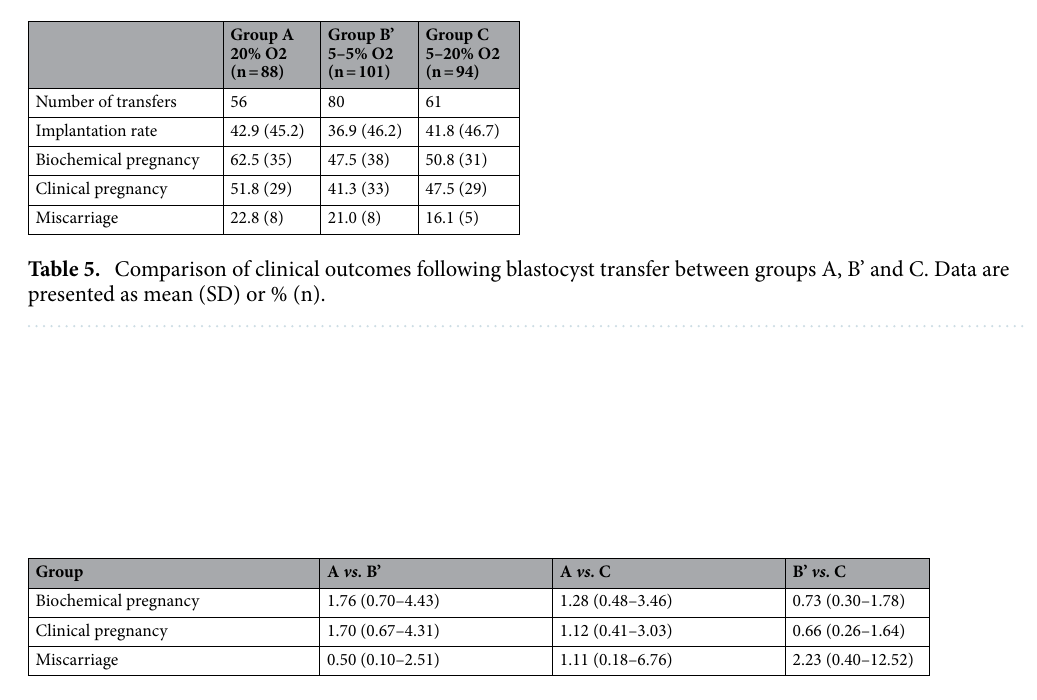
Table 6. Adjusted Odds-ratio and 95% CI from logistic model with adjustment for multiple comparisons of clinical outcomes following blastocyst transfer between groups A, B’ and C.